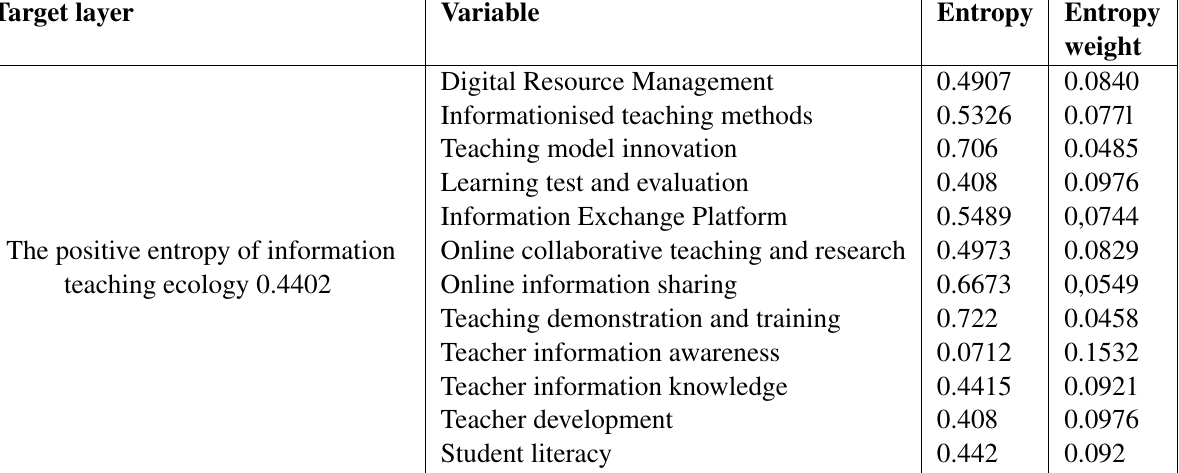
Table 1 Ecological positive entropy of informatisation teaching